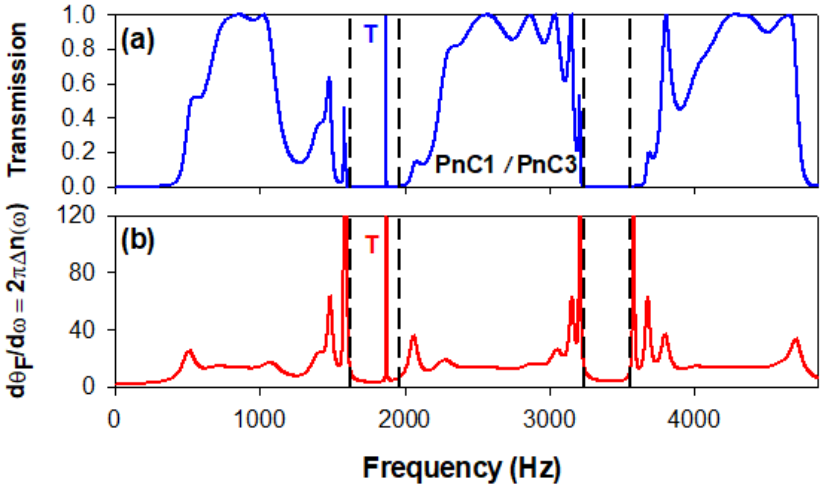
= d (cid:48) = 10 cm. ( b ) Variation of the 2 1